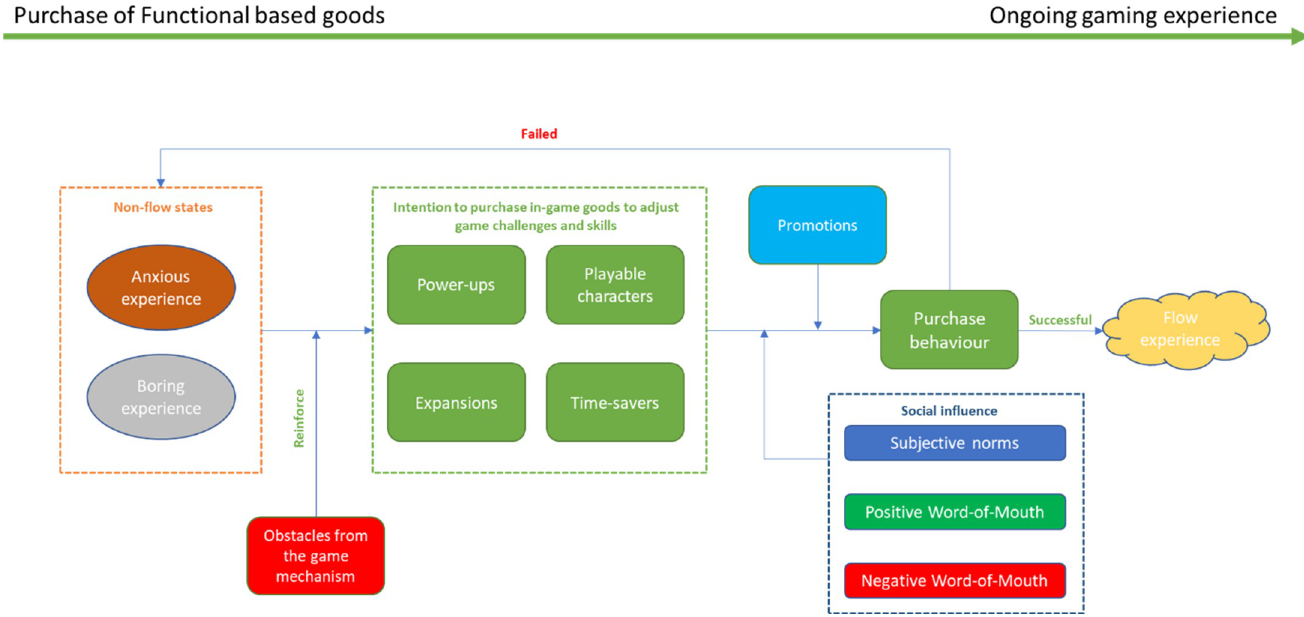
Fig 4. Purchase process between the non-flow state and actual purchase